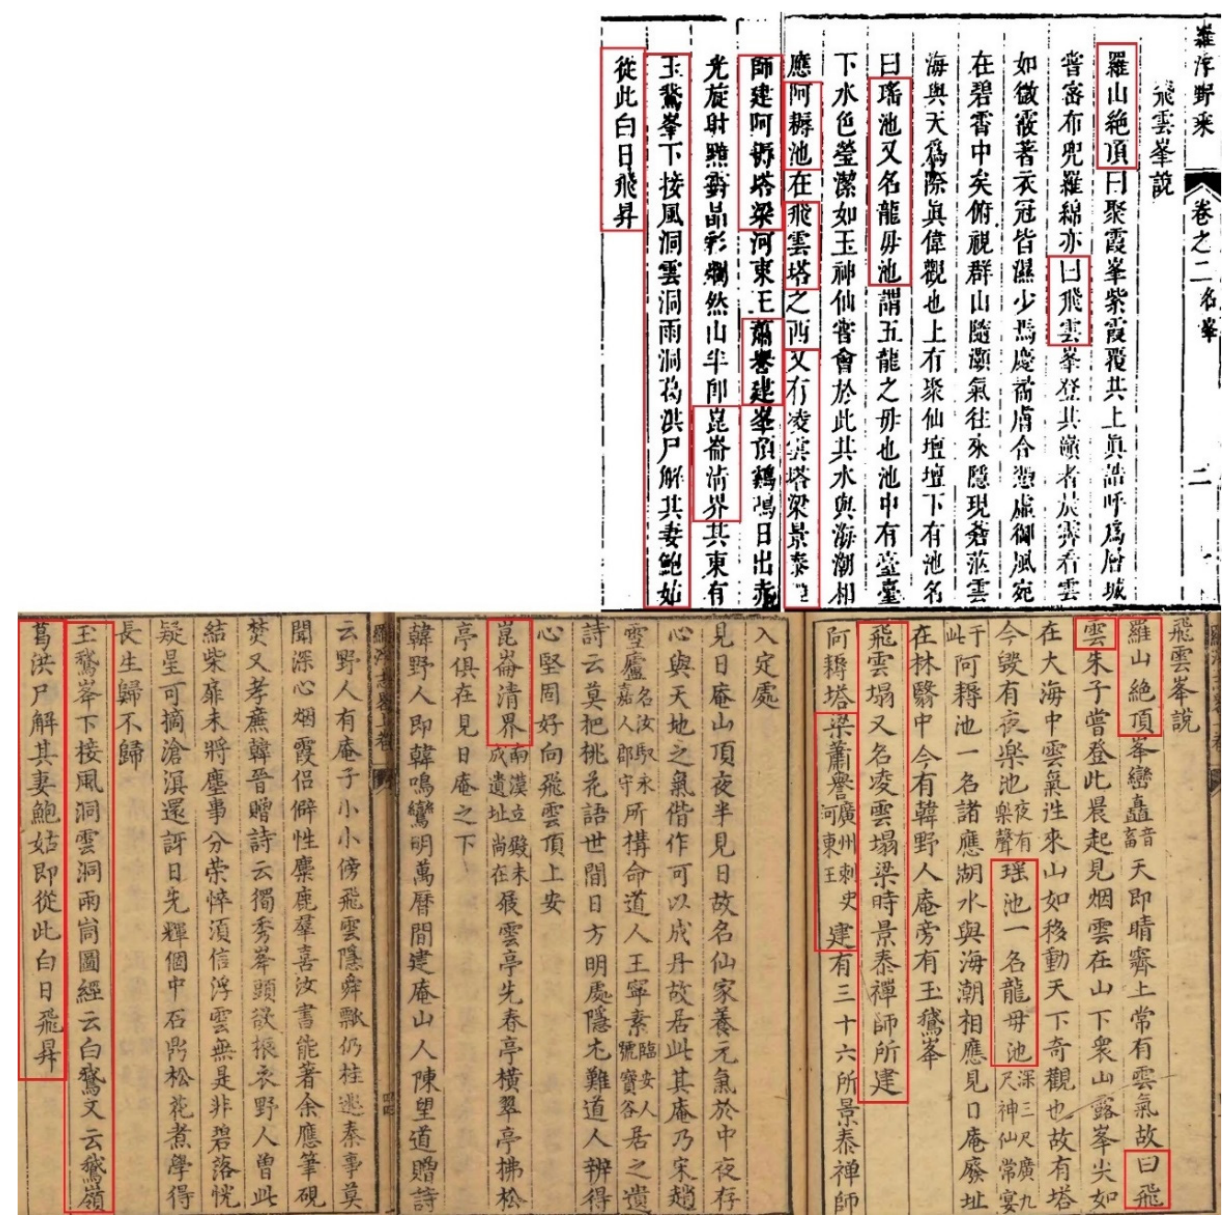
Figure 3. Comparison between the Feiyun Feng texts in Han Huang and Han Mingluan’s books. The red frames mark the same expressions in both texts. Upper: after Han Huang, Luofu yesheng , 2.8b (503), 2.10b (504); below: after Han Mingluan, Luofu zhi lue , 1.51b, 1.75b. Image edited by the